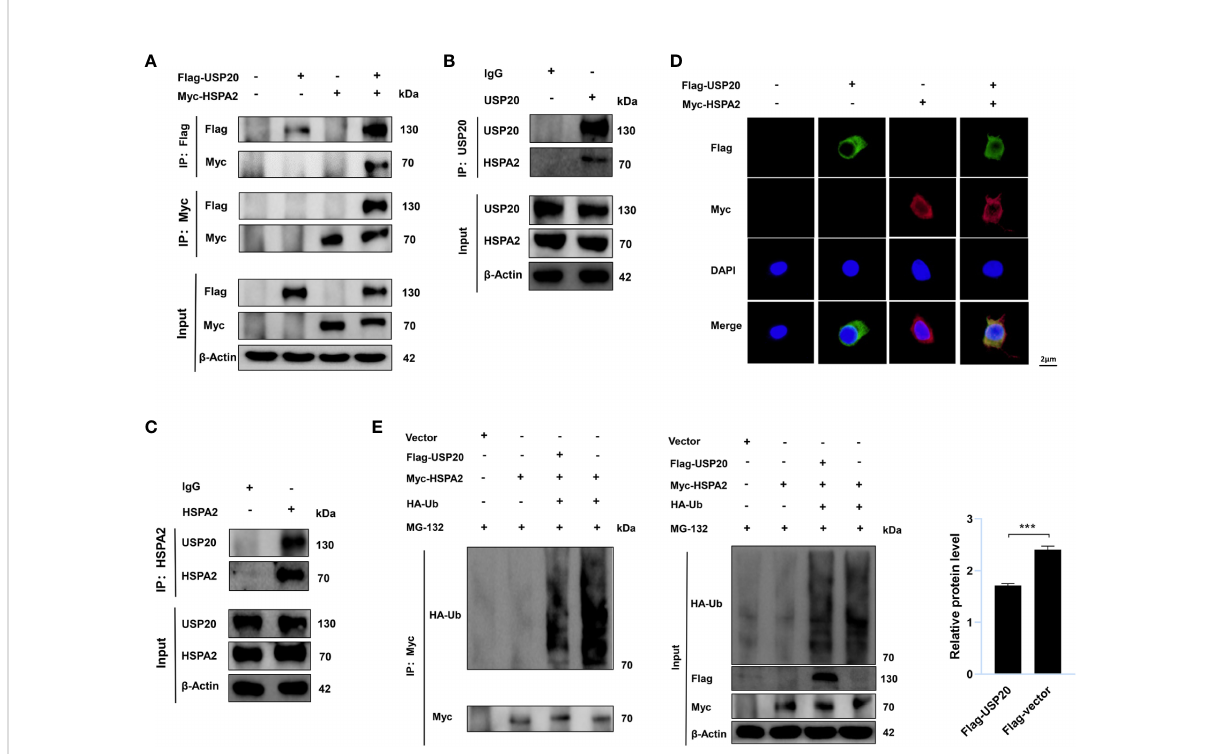
FIGURE 5 USP20 stabilizes HSPA2 via deubiquitination. (A) After 48h transfection of HEK293T cells with the indicated expression vectors, cellular lysates were analyzed by IP and immunoblotting with the indicated antibodies. (B, C) The lysates of HEK293T cells were analyzed by IP and immunoblotting with the indicated antibodies. (D) Transfection with the indicated expression vectors was performed in HEK293T cells. And 48h after transfection, indirect IF staining was performed with the indicated antibodies. Nuclear staining was performed with 4 ’ , 6-diamidino-2- phenylindole. Scale bars were shown in the fi gure. (E) Transfection with the indicated expression vectors was performed in HEK293T cells. After 48h, cells were treated with MG-132 (10 m M) for 6h and then analyzed by IP and immunoblotting with the indicated antibodies. Three times experiments were performed for above results. The data are expressed as mean ± SEM, Student ’ s t-test was used for intergroup comparisons. ***p <